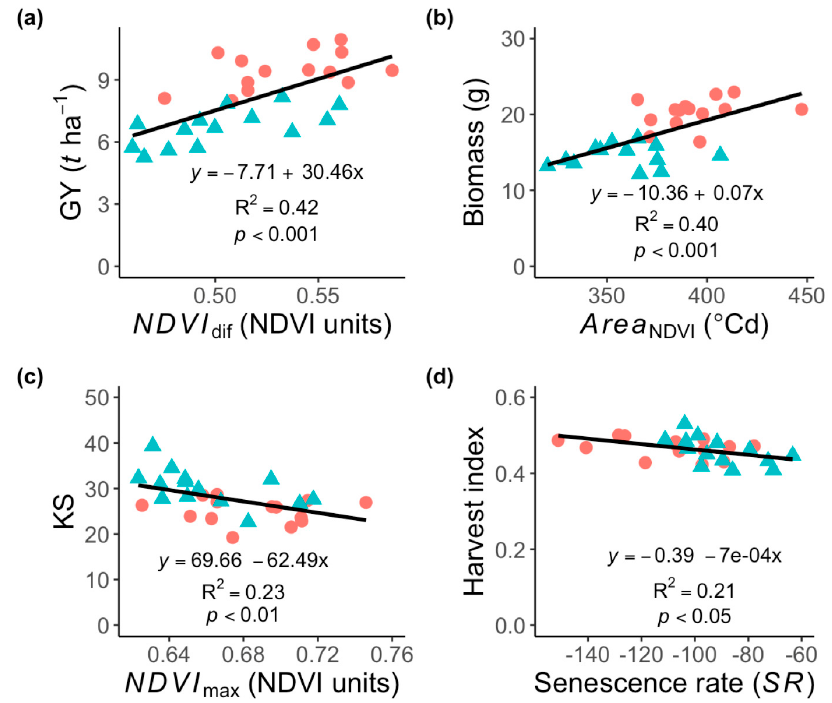
Figure 5. Relationship between agronomical and canopy senescence traits associated to stay-green expression in fourteen spring bread wheat genotypes growth under field condition. ( a ) Association between grain yield (GY) and NDVI dif , ( b ) biomass and Area NDVI , ( c ) kernels per spike (KS) and NDVI max and ( d ) harvest index and senescence rate ( SR ) in the field experiment. Closed symbols represent the well-watered ( circles ) and water-limited ( triangles ) irrigation.